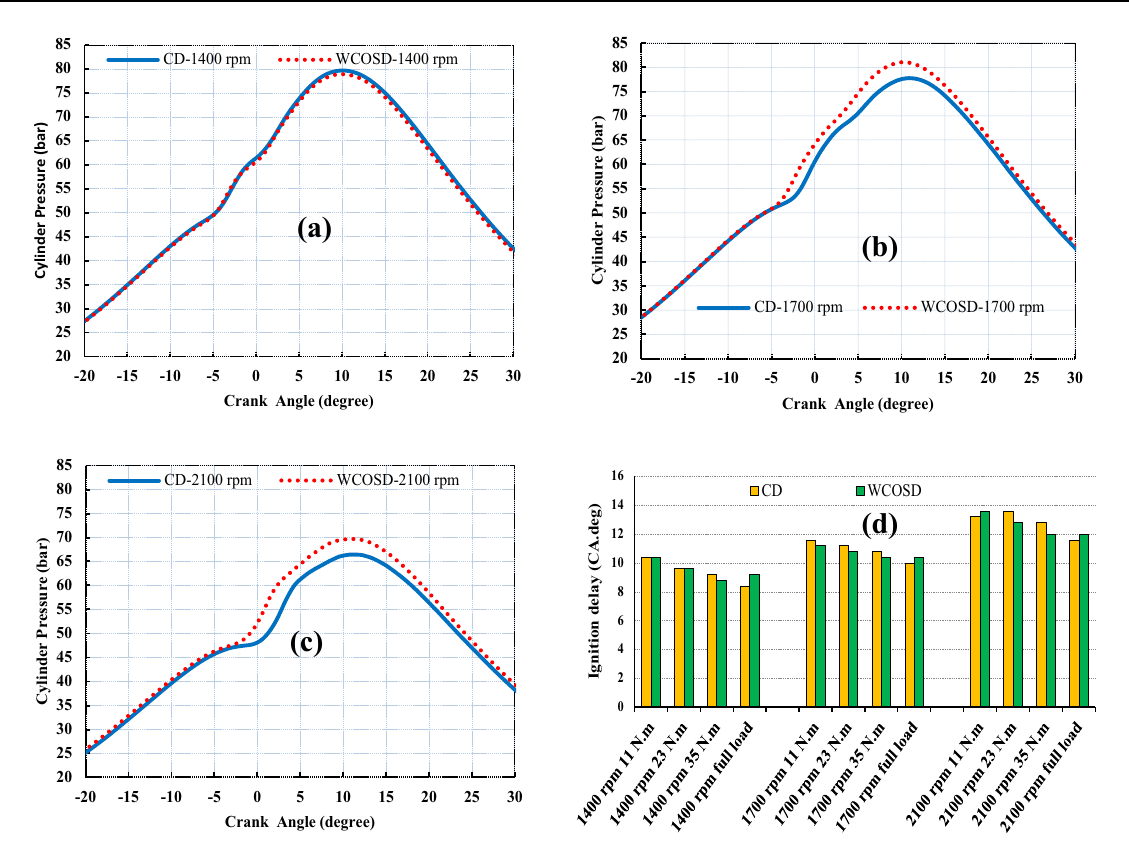
Fig. 6 Variation of in-cylinder pressure of the test engine fueled CD and WOCSD at a 1400 rpm, b 1700 rpm, c 2100 rpm, and d ignition delay at different operating conditions